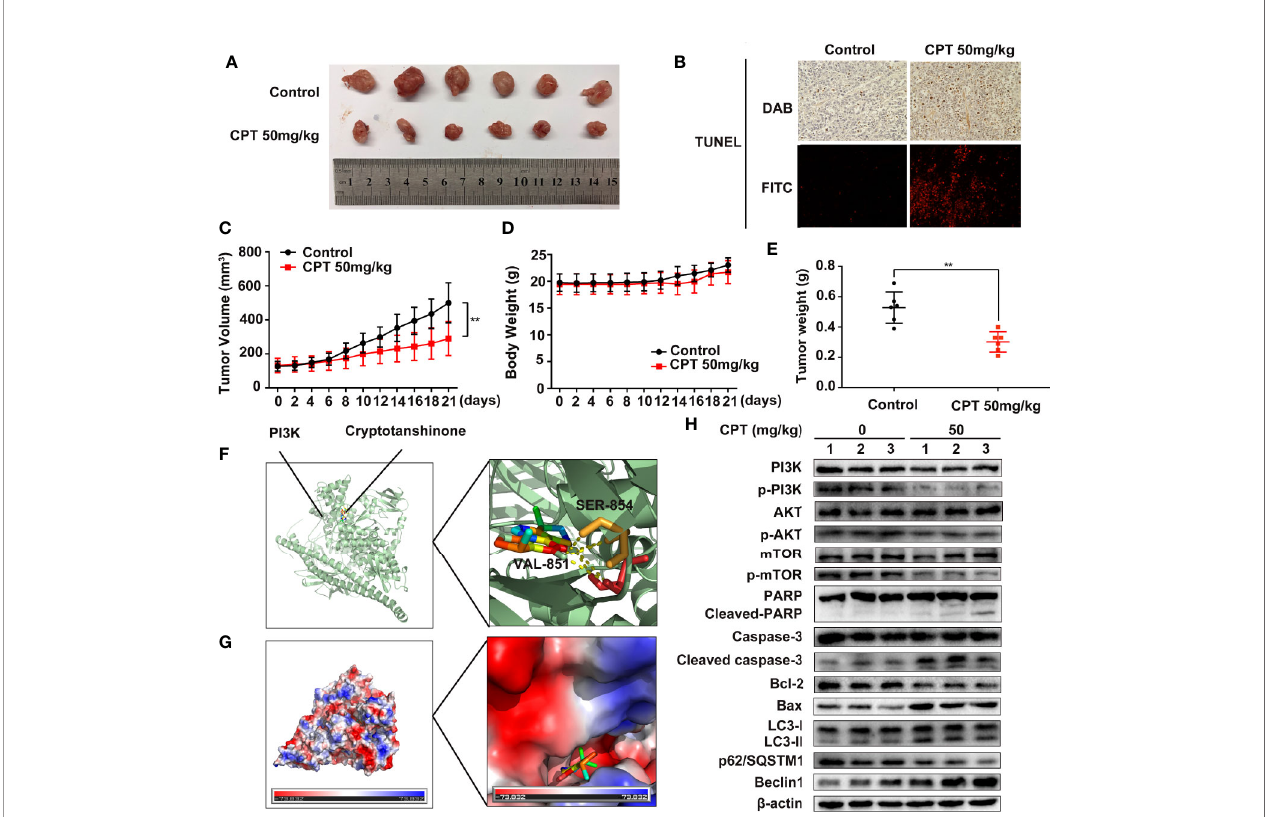
FIGURE 11 | Cryptotanshinone (CPT) inhibits the growth of Huh7 cell xenografts in nude mice. (A) Photograph of extracted tumors from each group of mice (n = 6). Statistical analysis of tumor volumes (C) , body weight (D) , and tumor weight (E) in each group of mice (n = 6). (B) TUNEL assays were conducted to measure apoptosis in tumor tissues using immunochemistry and immuno fl uorescence analyses. (F) The binding mode of CPT with phosphatidylinositol 3-kinase (PI3K) determined by molecular docking simulation. CPT formed stable hydrogen bonds with PI3K at SER-854 and VAL-851. (G) Electrostatic surfaces of CPT and PI3K obtained using Pymol. Lower electrostatic potential denotes better binding ability. (H) Tumor tissue lysates were extracted from the control and CPT-treated groups and the expression levels of PI3K, p-PI3K, AKT, p-AKT, mTOR, p-mTOR, PARP, cleaved PARP, caspase-3, cleaved caspase-3, Bcl-2, Bax, LC3-I, LC3-II, p62/ SQSTM1, and Beclin1 proteins were assessed by western